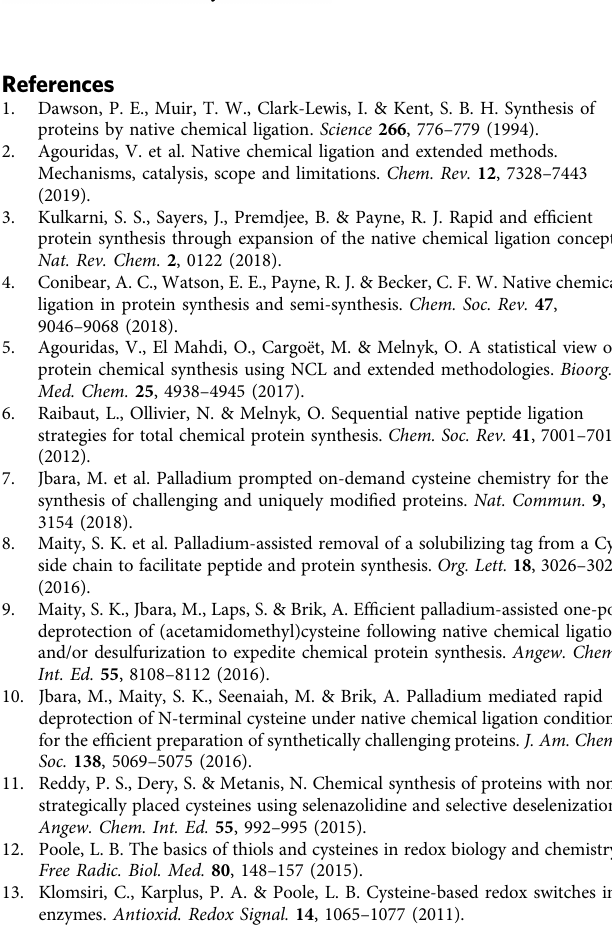
Fig. 6e are representative of two independent experiments. Scattering assays (Fig. 6f) The assay was performed according to Simonneau et al. 47 . Capan cells were seeded at low density (2000 cells/well on a 12-well plate) to form compact colonies. After treatment, when colony dispersion was observed, the cells were fi xed and colored by Hemacolor ® stain (Merck, Darmstadt, Germany) according to the manufacturer ’ s instructions. Representative images were captured using a phase contrast microscope with ×40 and ×200 magni fi cation (Nikon Eclipse TS100, Tokyo, Japan). The data presented in Fig. 6f are representative of two independent